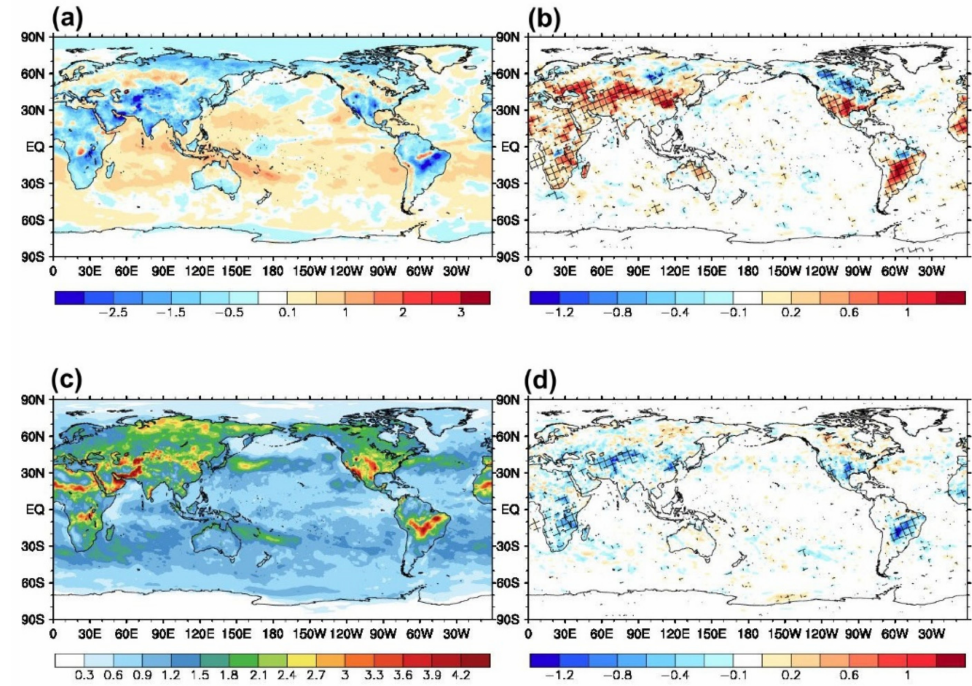
Figure 8. ( a ) Biases and ( c ) RMSEs of 2-m-specific humidity in the CTL against the ERA5 reanalysis, and ( b ) differences in the biases and ( d ) RMSEs between the EXP and CTL over the period of 1 July 2019 to 10 August 2019 for a five-day forecast. The hatched regions indicate a difference significant at the 95% confidence